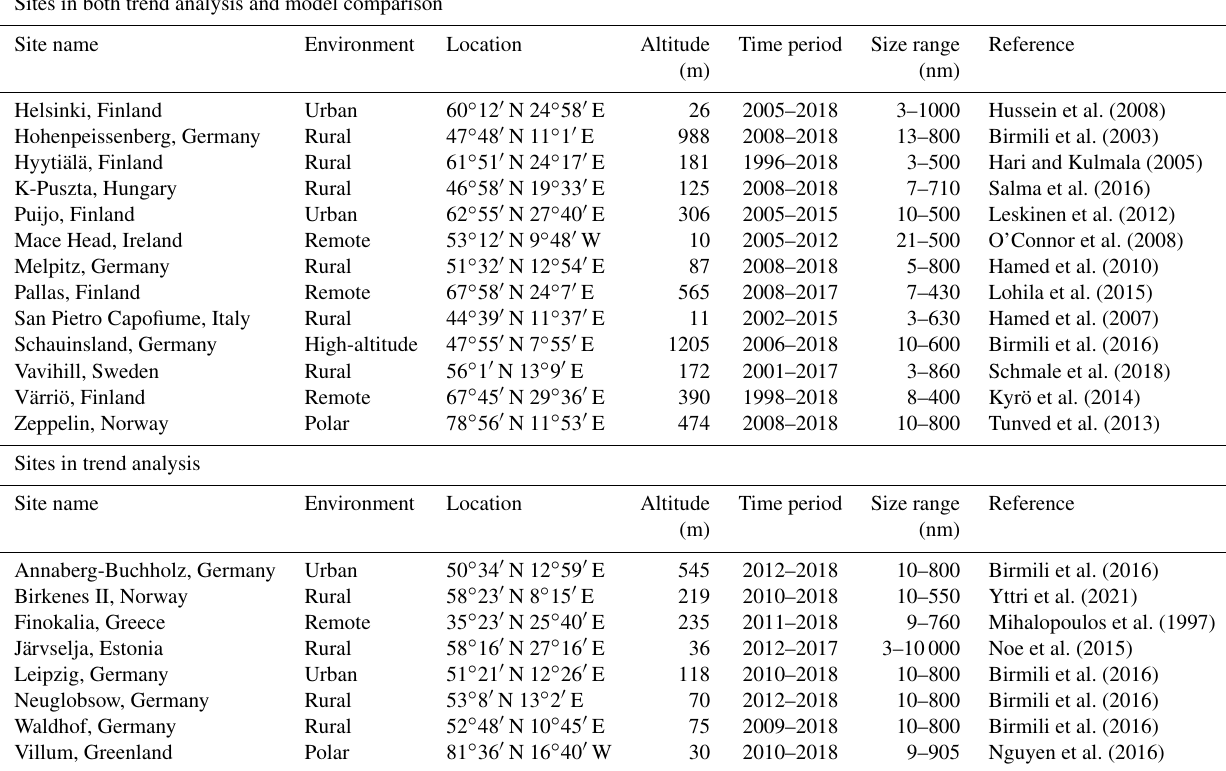
Table 1. Information of measurement sites used in this study. Site name, site environment type, coordinates, altitude in metres above sea level, time period, and size range (rounded to the nearest nanometre for minimum size and nearest 10nm for maximum size) covered. Sites in both trend analysis and model